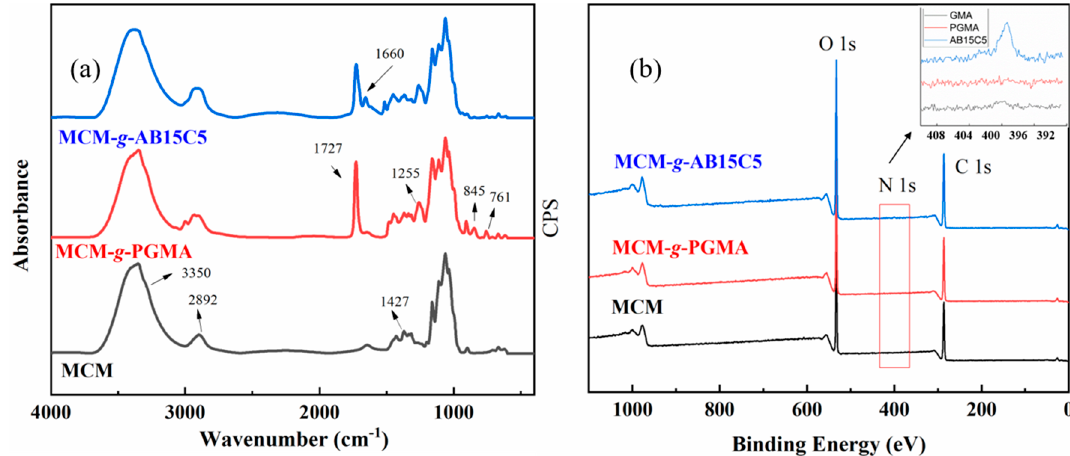
Figure 4. FTIR spectra ( a ) and XPS spectra ( b ) for MCM, MCM- g -PGMA and MCM- g -AB15C5.